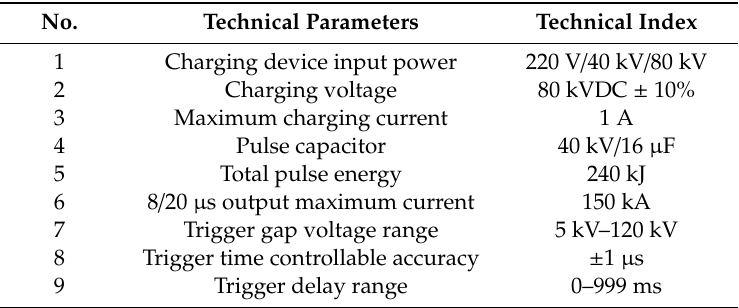
Table 1. The main technical parameters of the experimental setup.